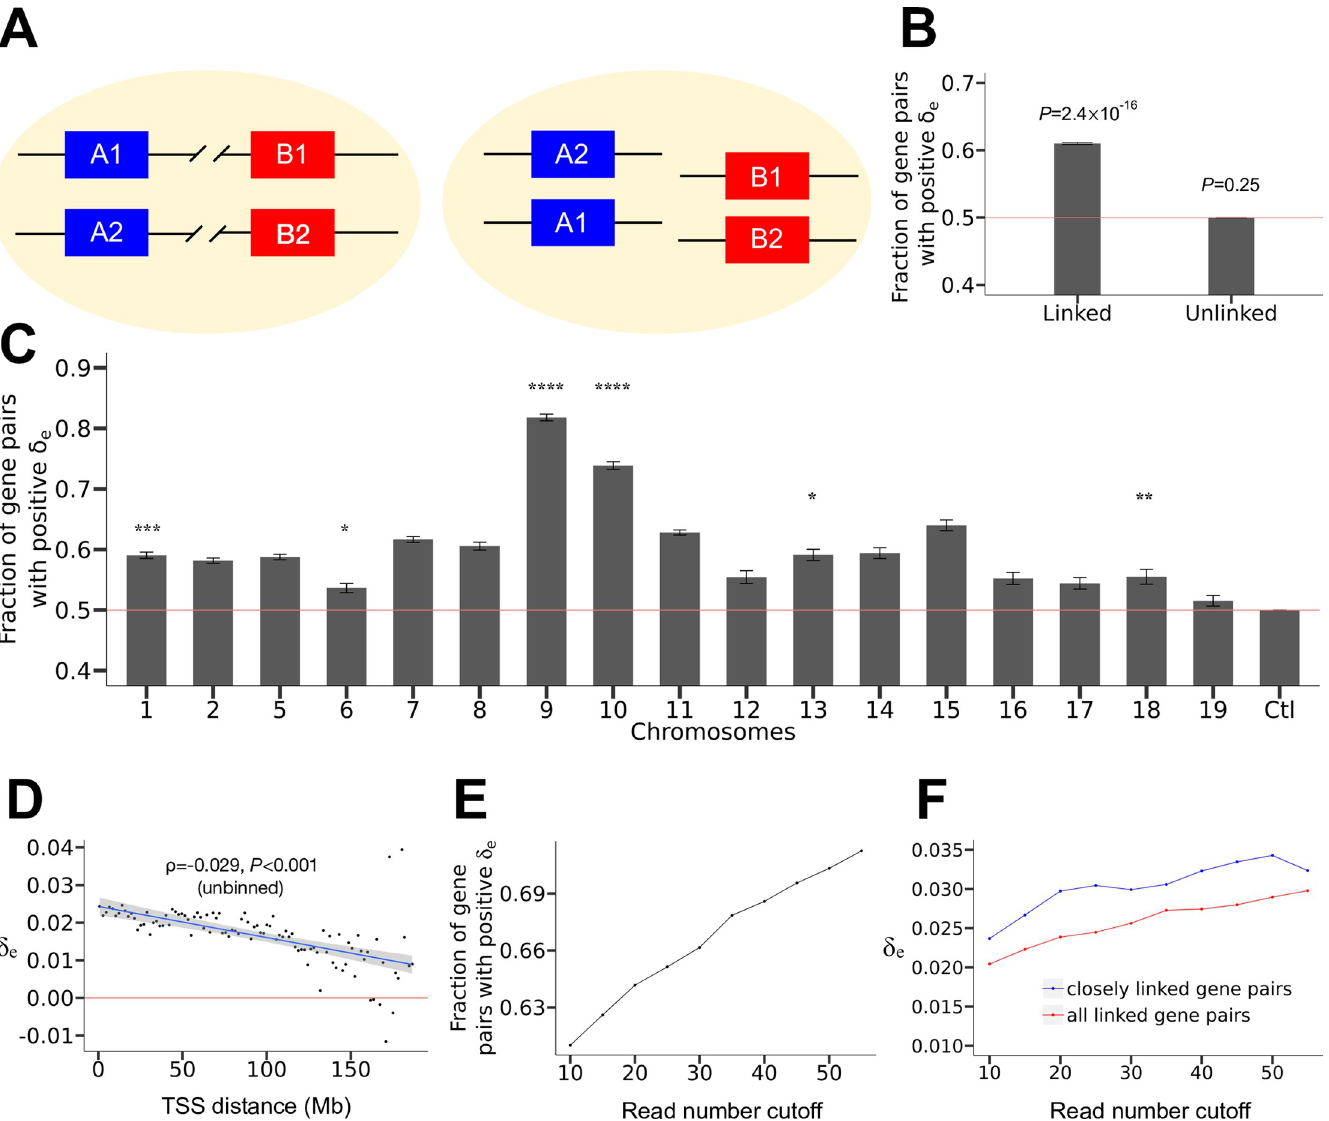
Fig 2. Chromosome-wide linkage effects on gene expression co-fluctuation in mouse fibroblast cells. (A) The logic of the method for testing the linkage effect. When gene A and gene B are linked, the correlations between the mRNA concentrations of the alleles of A and B that are physically linked ( cis -correlations) should exceed the corresponding correlations of the alleles that are physically unlinked ( trans -correlations). That is, δ e = (sum of cis -correlations − sum of trans -correlations)/2 should be positive. This relationship should disappear if gene A and gene B are unlinked. For each gene, the paternal and maternal alleles are labeled by 1 and 2, respectively. (B) Fraction of gene pairs with positive δ e . The red line represents the null expectation under no linkage effect. The 95% confidence intervals estimated from all gene pairs are presented. P -values from binomial tests on independent gene pairs are presented. (C) Fraction of gene pairs with positive δ e in each chromosome. The 95% confidence intervals estimated from all gene pairs are presented. Binomial P -values estimated from independent gene pairs are indicated as follows. NS, not significant; � , 0.01 < P < 0.05; �� , 0.001 < P < 0.01; ��� , 0.0001 < P < 0.001; and ���� , P < 0.0001. The red line represents the null expectation under no linkage effect. The control (Ctl) shows the fraction of unlinked gene pairs with positive δ e . (D) Median δ e in a bin decreases with the median genomic distance of linked genes in the bin. All bins have the same genomic distance interval. TSS, transcription start site. The red line shows median δ e = 0. The blue line shows the linear regression of the binned data, and the 95% confidence interval of the regression is presented. Spearman’s ρ from unbinned data and associated P -value determined by a shuffling test are presented. (E) Fraction of linked gene pairs showing positive δ e increases with the minimal number of reads per allele required ( P < 10 − 300 ). (F) Median δ e for all linked gene pairs (red) and median δ e in the left-most bin of panel D (blue) increase with the minimal read number per allele required (both P < 10 − 300